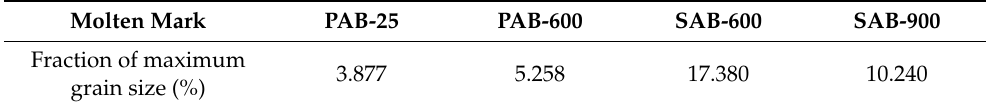
Table 3. Average fraction of maximum grain size in each molten mark. Molten Mark